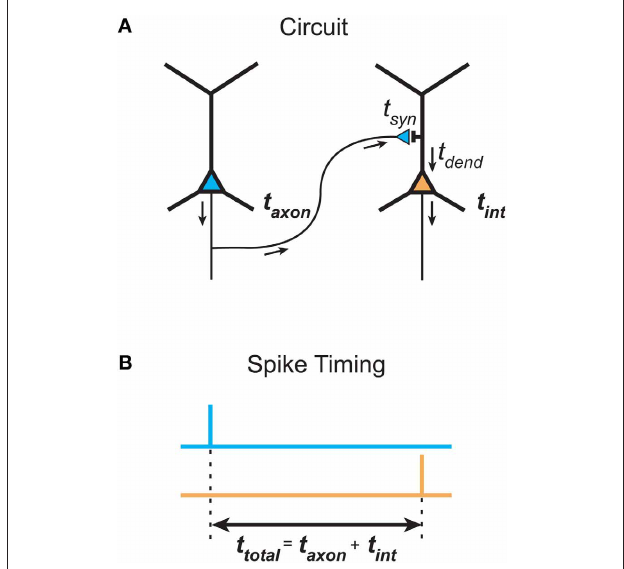
FIGURE 6 | Total communication delay between neurons separable into a presynaptic axonal conduction delay and a postsynaptic neuronal integration delay. (A) Schematic circuit diagram shows the time taken by an action potential generated in the presynaptic neuron (left neuron, blue) to propagate along the axon to a presynaptic terminal, where it causes the release of neurotransmitter into the synaptic cleft, defines the axonal conduction delay ( t axon ). The postsynaptic neuronal integration delay ( t int ) is the sum of the time taken for neurotransmitter molecules to induce a local postsynaptic response (synaptic delay, t syn ) and the latency for this response to propagate down the dendritic tree to the axon initial segment, where its integration produces an action potential in the postsynaptic neuron (right neuron, orange) (dendritic delay, t dend ). (B) Total delay ( t total ) between the timing of a presynaptic spike occuring (top, blue line) and the generation of a postsynaptic spike (bottom, orange line) is determined by the sum of presynaptic and postsynaptic delay